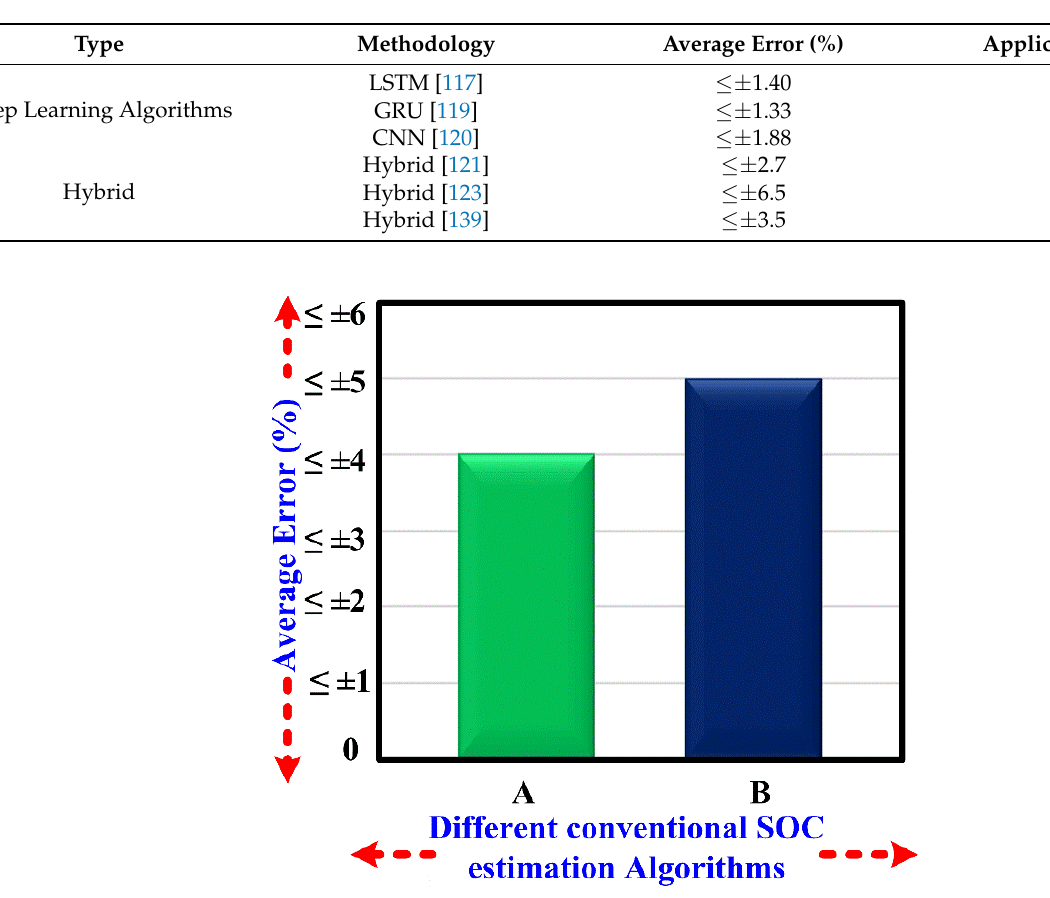
Figure 12. Comparison between the different learning SOC estimation algorithms. “A” is referred to as [137], “B” is referred to as [46], “C” is referred to as [106] and “D” is referred to as [138].